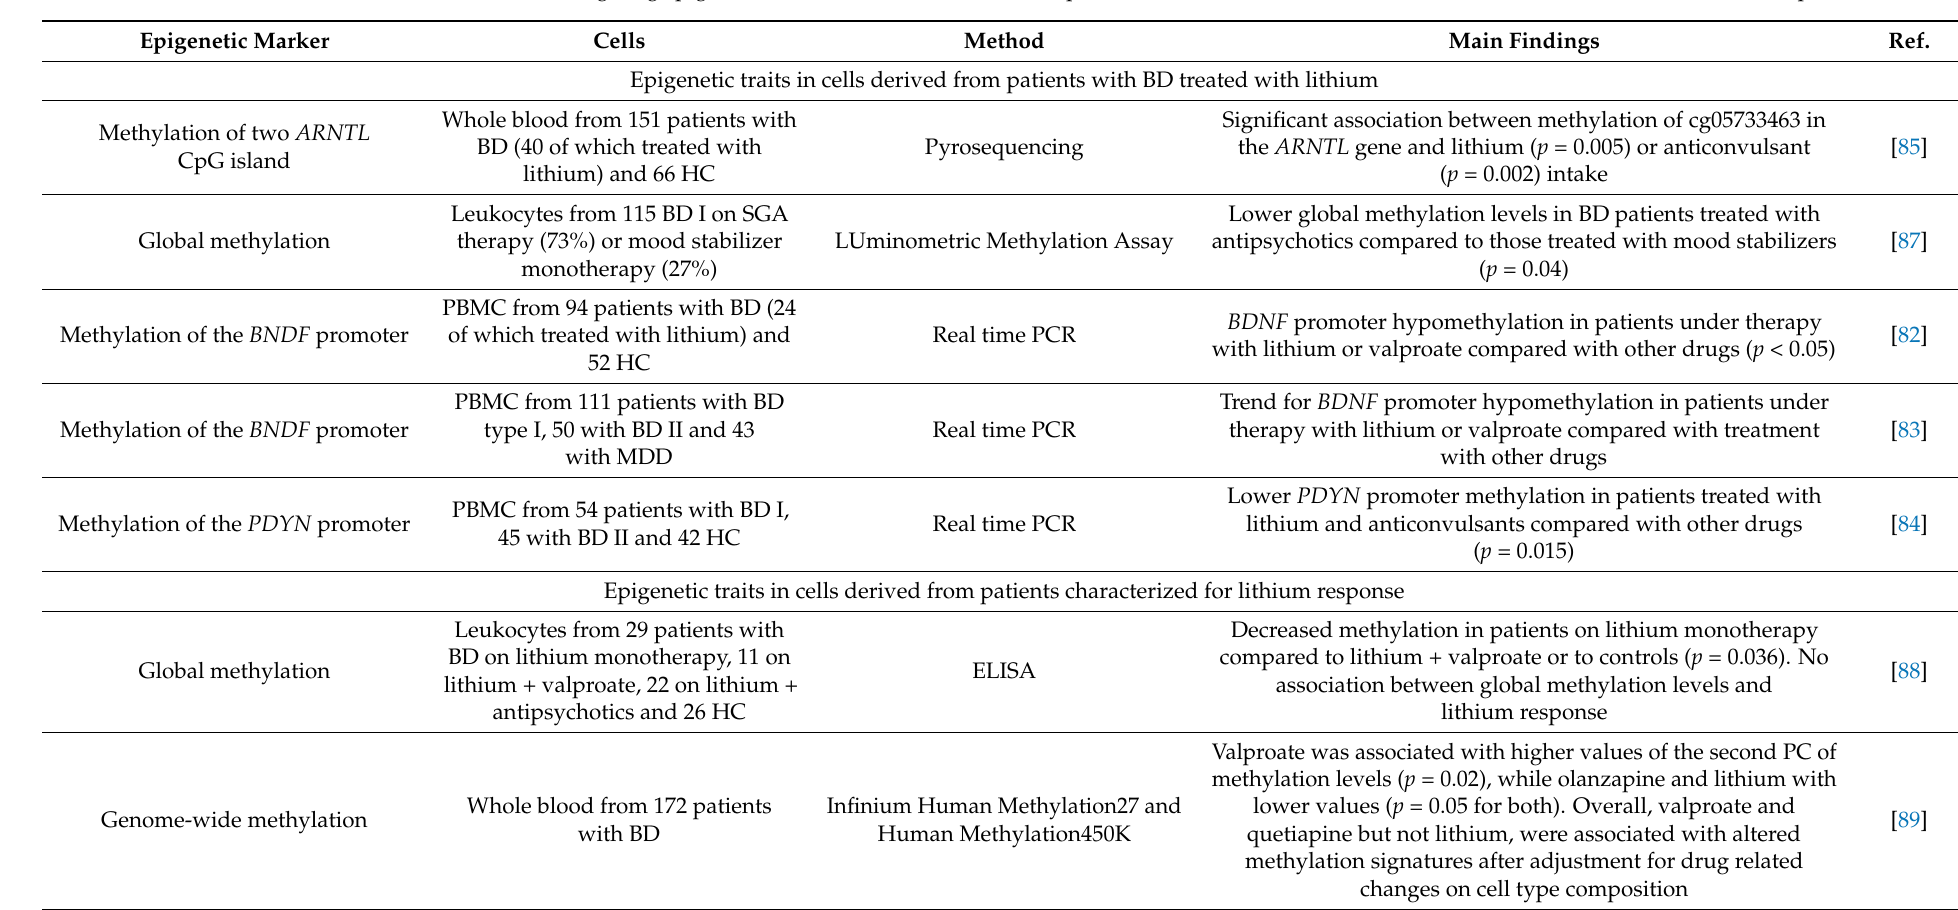
Table 3. Studies investigating epigenetic markers in cells derived from patients with BD treated with lithium or other human-derived cell lines exposed to